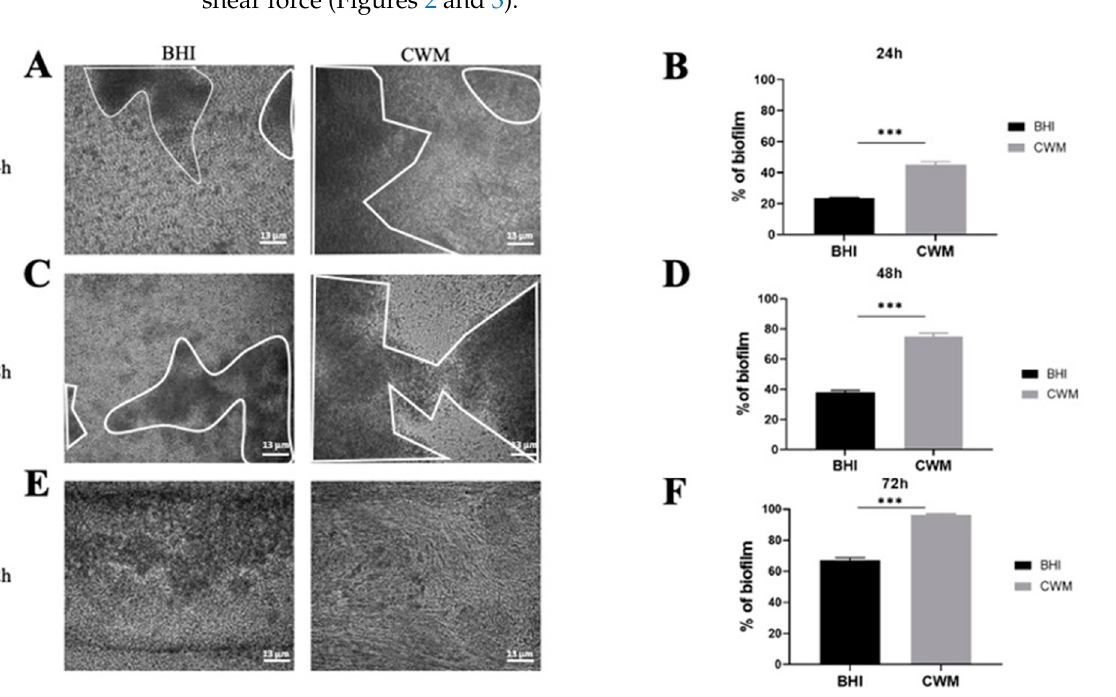
Figure 2. Kinetics of the biofilm formation of Staphylococcus aureus Newman in the BioFlux TM system. ( A , C , E ) correspond to representative images taken at different times (( A ) 24 h; ( C ) 48 h and ( E ) 72 h) of biofilm formation in the CWM and BHI media. The images are the result of one of the three experimental triplicates. Biofilm is visualized by the black part in between the white lines. Percentages of biofilm formation are presented at 24 h ( B ), 48 h ( D ) and 72 h ( F ) postincubation in both media after three independent experiments. They were determined by the ImageJ software application. Results are presented as the mean ± standard deviation. Statistics were performed using a t -test on GraphPad Prism version 7. Ns, p > 0.05; *** p < 0.001.